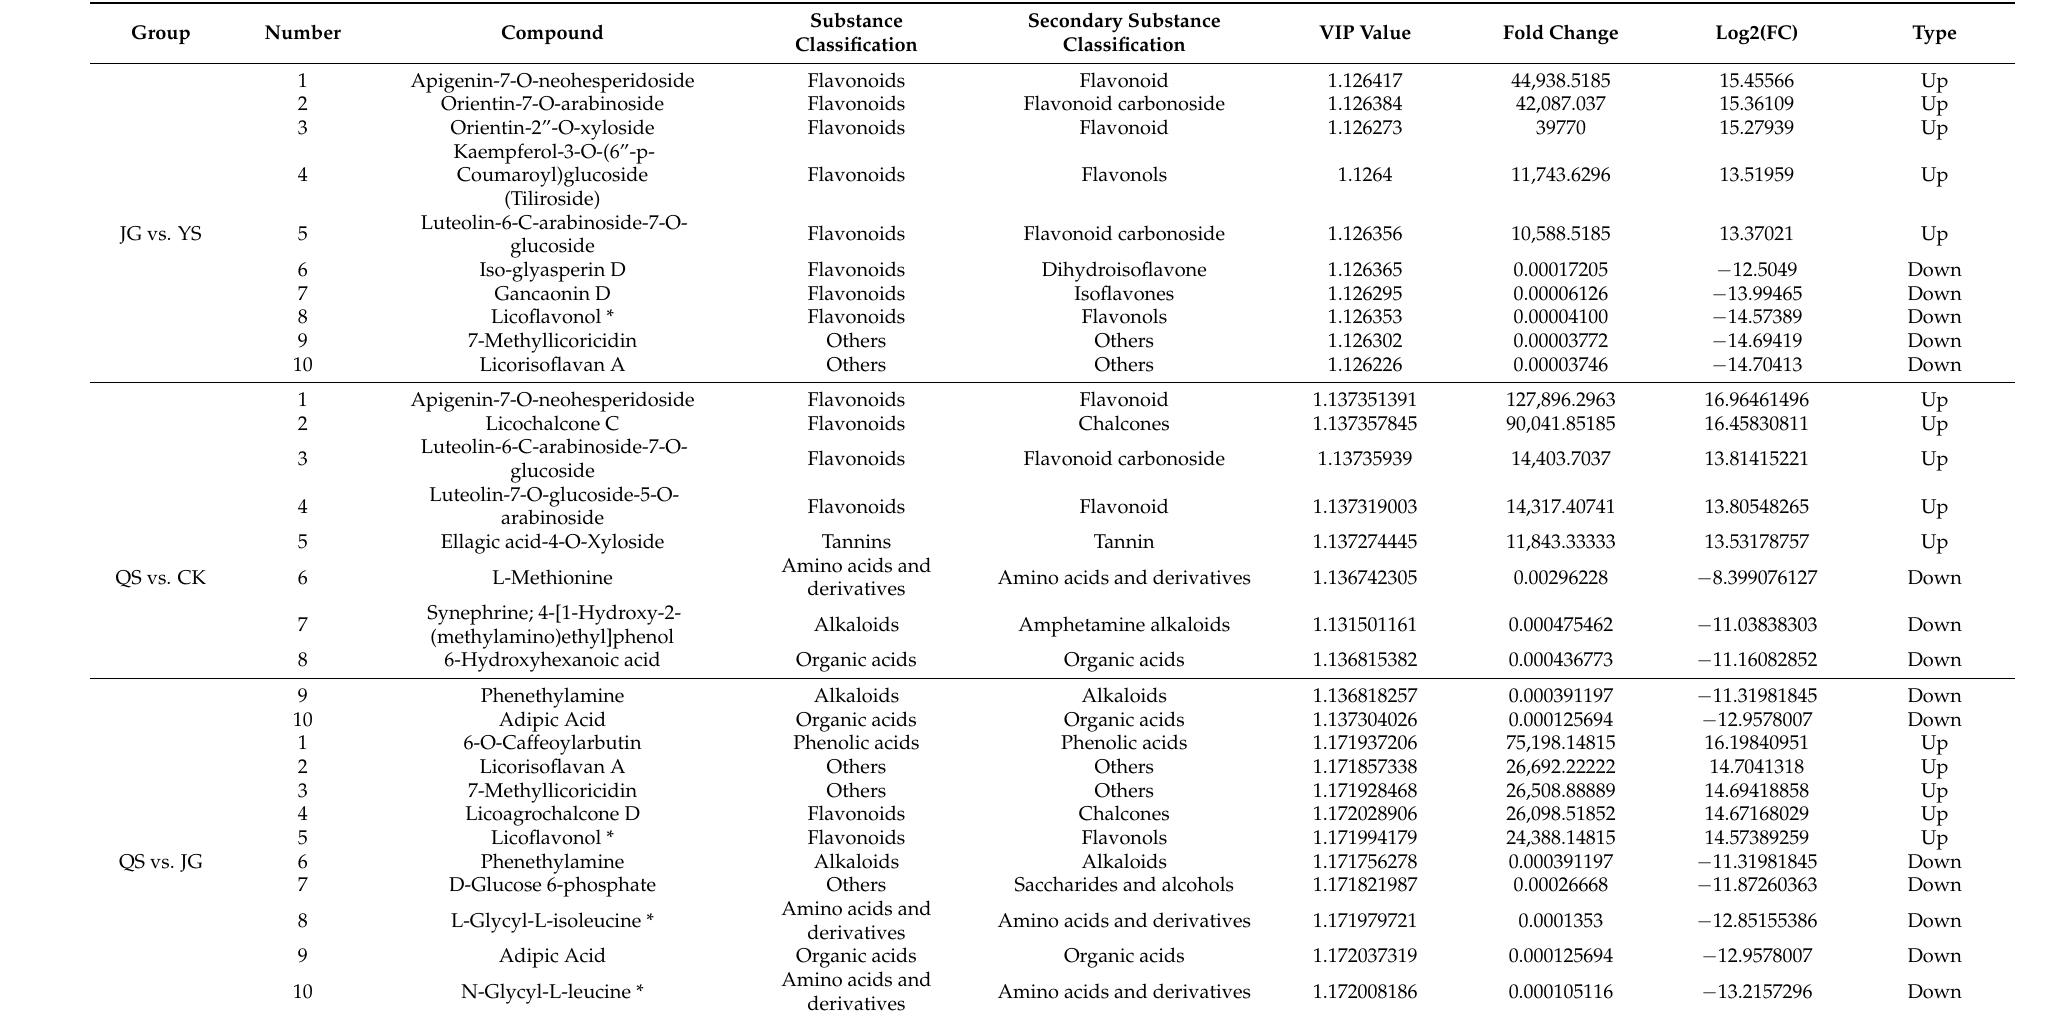
Table 1. Differential metabolites of the top 10 different multiples in different LXH samples as identified by VIP score and